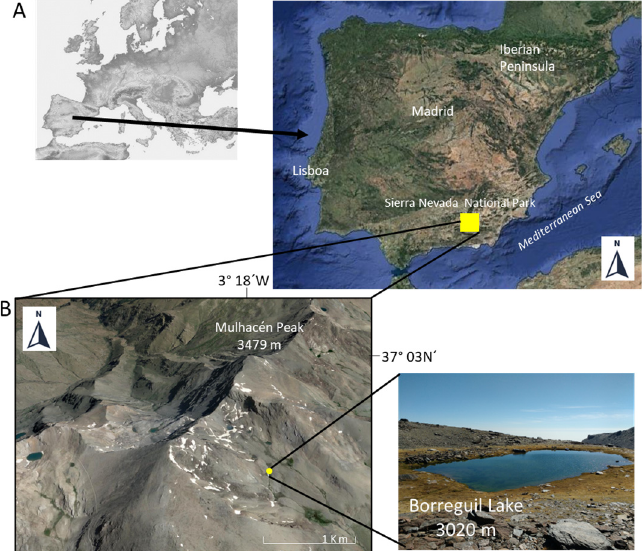
Figure 1. ( A ) Map of Europe and map of the Iberian Peninsula showing the location of the study area. ( B ) Geographic location of Borreguil Lake in Sierra Nevada National Park (Spain). Source Google Earth Pro, image: Landsat/Copernicus, imagery data 14 December 2015. Borreguil Lake photograph (E. Corral ‐ Arredondo, 25 September 2017) taken from https://lagunasdesierranevada.es/ (accessed on 10 October 2022).